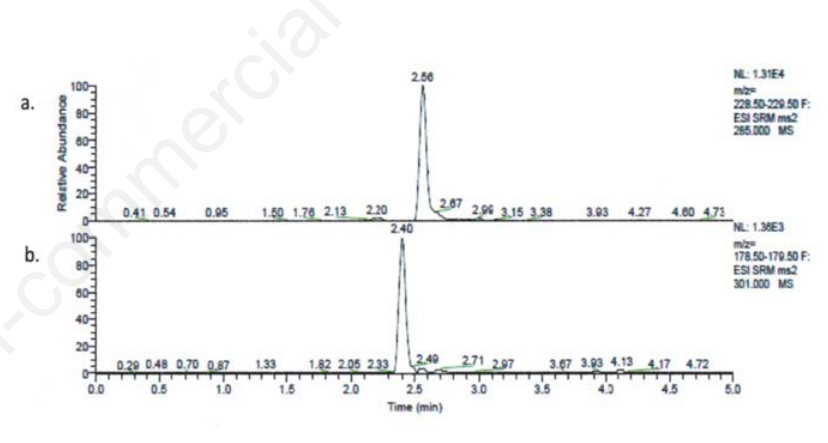
Figure 2. Results of HPLC buds 1 M. malabathricum L. (K 1) (a) Quercetin, (b) kaempferol.